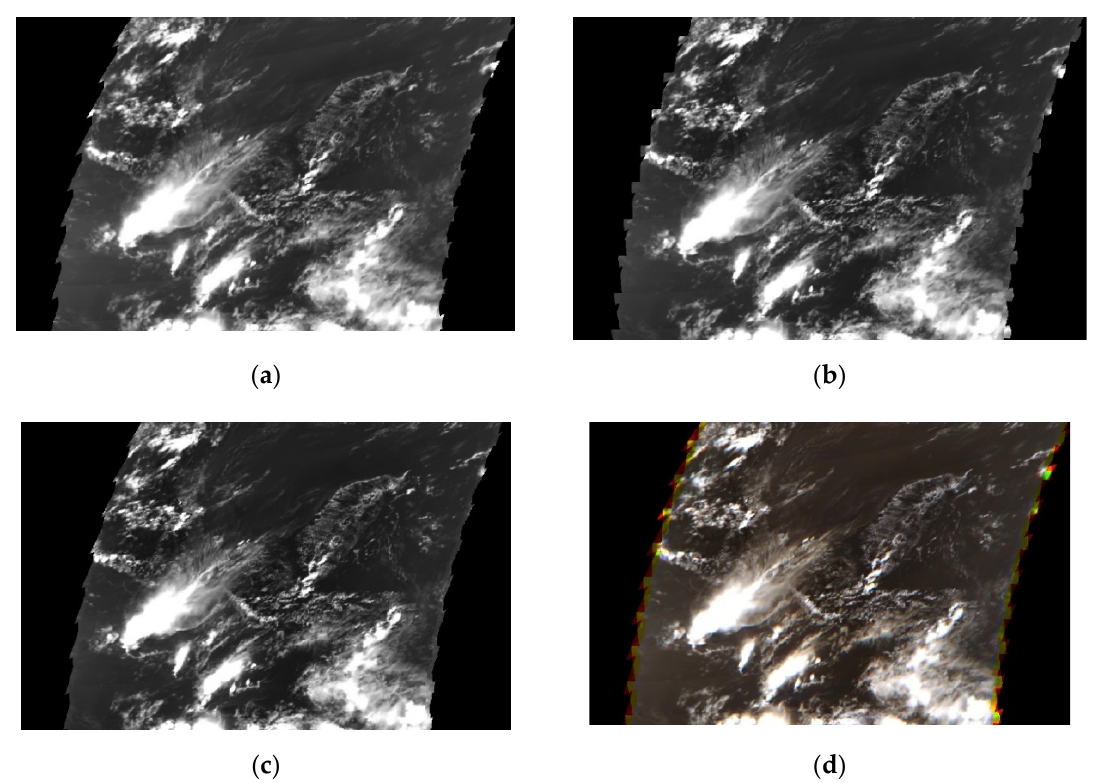
Figure 3. Examples of DPC imagery from different angles. ( a – c ) DPC imagery of 1 (cid:3035) -angle, 2 (cid:3035) -angle and 3 (cid:3047)(cid:3035) -angle, ( d ) pseudo-color composite image of 1 (cid:3035) -angle, 2 (cid:3035) -angle and 3 (cid:3047)(cid:3035) -angle. The pseudo-color image shows that the edge zone of the images from different angles does not overlap. These areas lacking certain angle information are invalid edge areas.